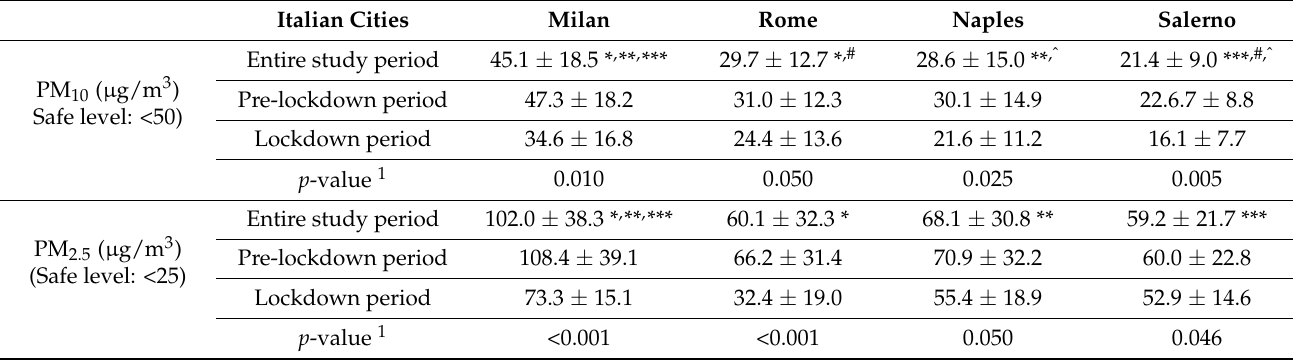
Table 2. Average PM 10 and PM 2.5 concentrations in Milan, Rome, Naples, and Salerno during the pre-lockdown